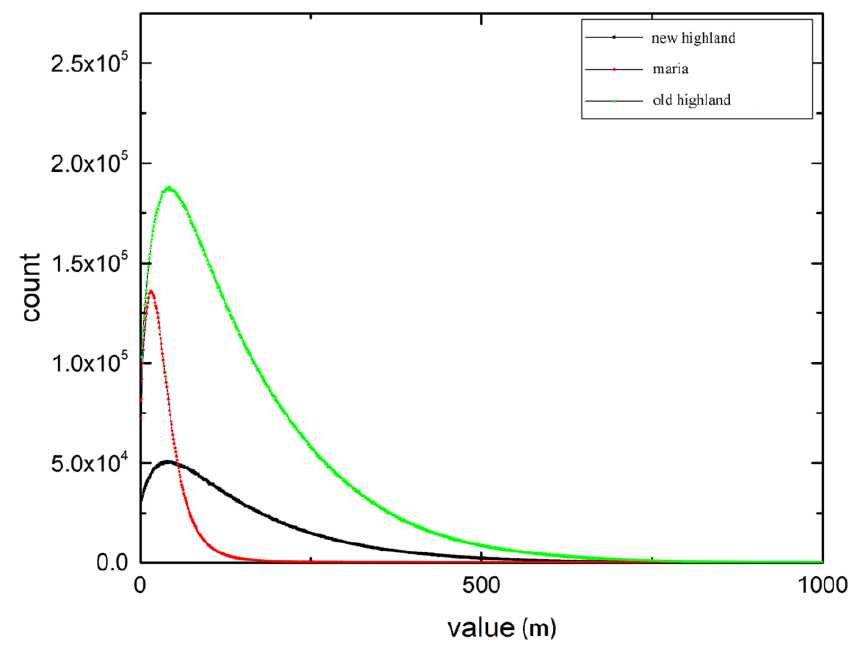
Figure 5. Fluctuation statistics of the three regions